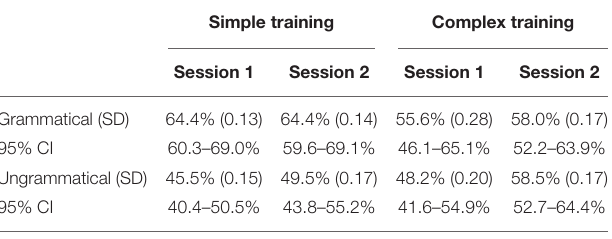
TABLE 5 | GJT response patterns by training condition for item endorsement across sessions.